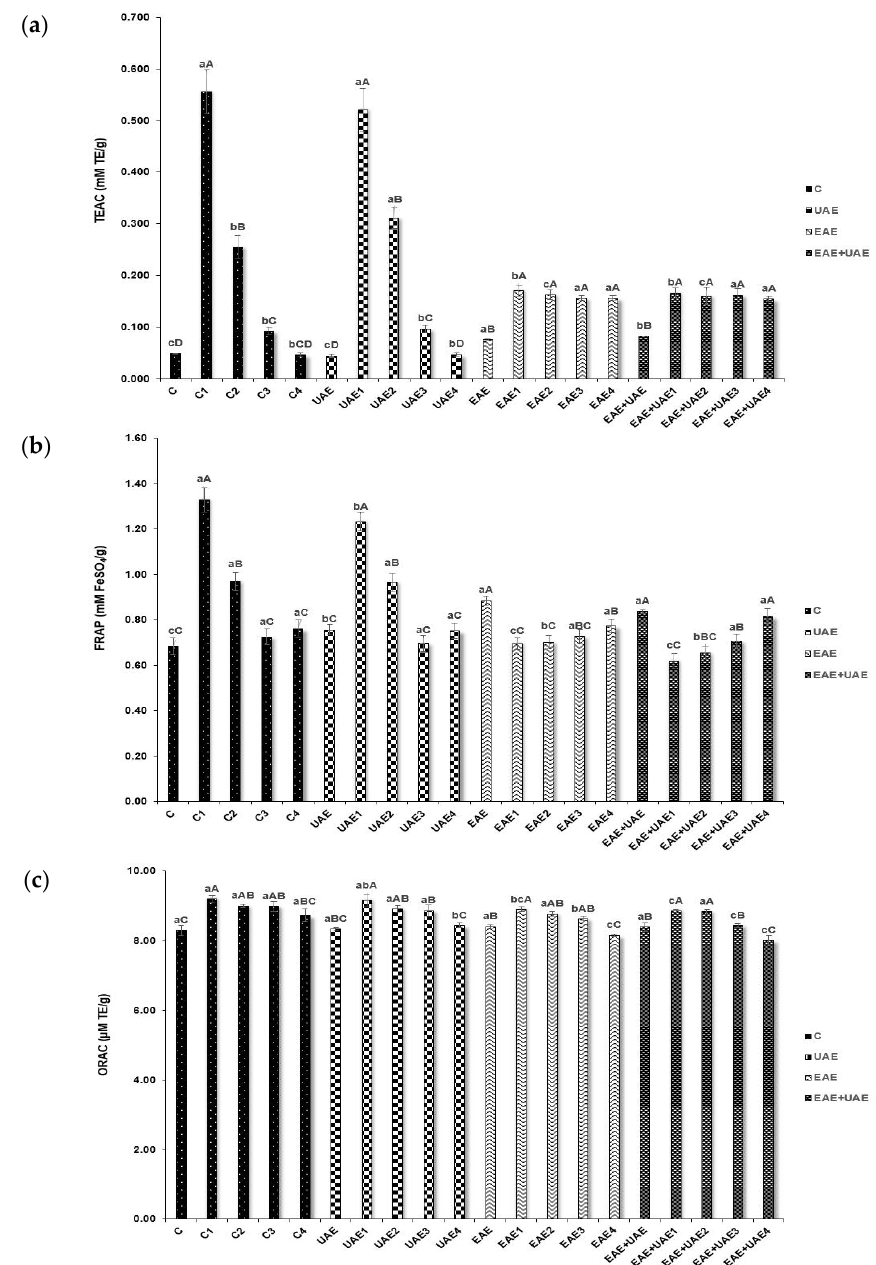
Figure 1. Antioxidant properties of collagen hydrolysate fractions extracted from APS. ( a ) TEAC, ( b ) FRAP, ( c ) ORAC. Results are calculated with means of three replications ± standard deviation. C, control; UAE, ultrasound assisted extraction method; EAE, enzyme assisted extraction method; EAE+UAE, combination of enzyme and ultrasound assisted extraction methods. 0; Crude extract, 1; ≤ 3 kDa, 2; 3–10 kDa, 3; 10–30 kDa, 4; ≥ 30 kDa. Same lowercase letters represented no significant difference between extraction procedures within protein fractions, and same capital letters represented no significant difference between protein fractions within extraction procedure.